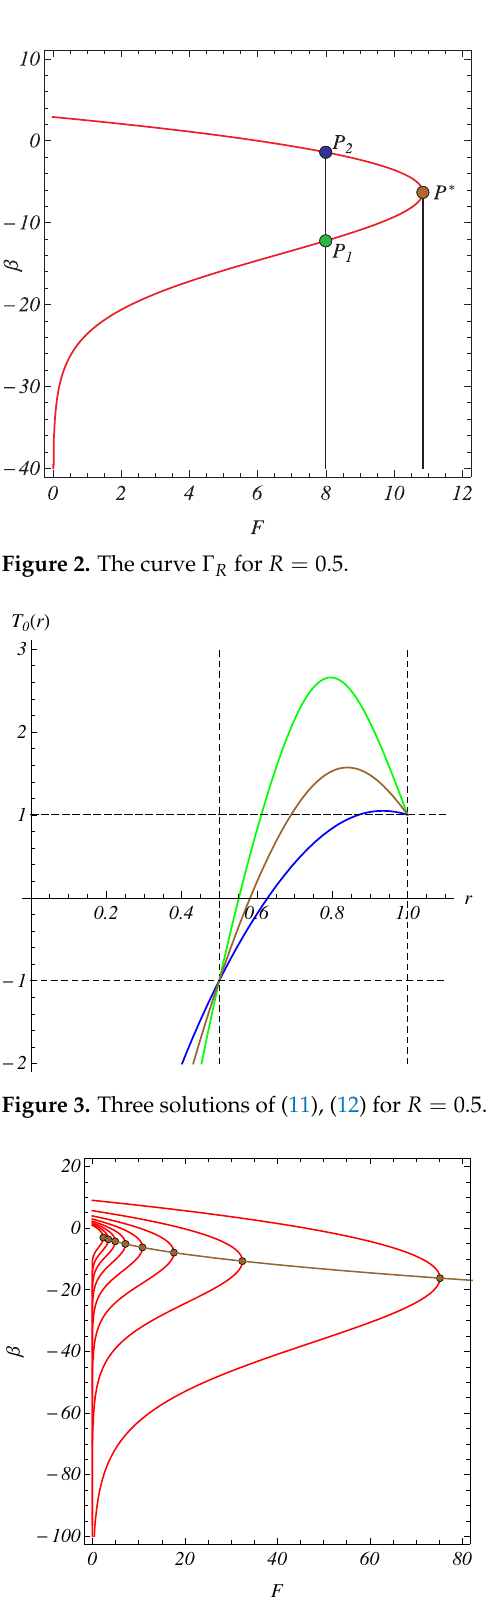
Figure 4. Evolution of the curves Γ R for R = 0.1 j , j ∈ { 1,2, . . . ,9 }